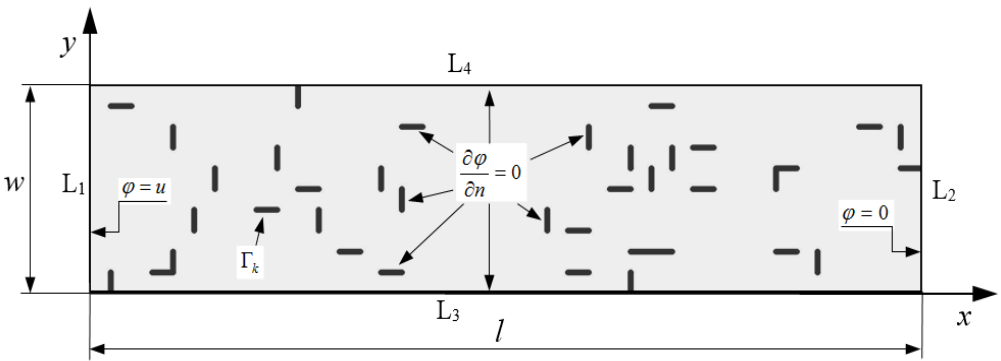
Figure 2. The analyzed model of the conducting stripe with defects.